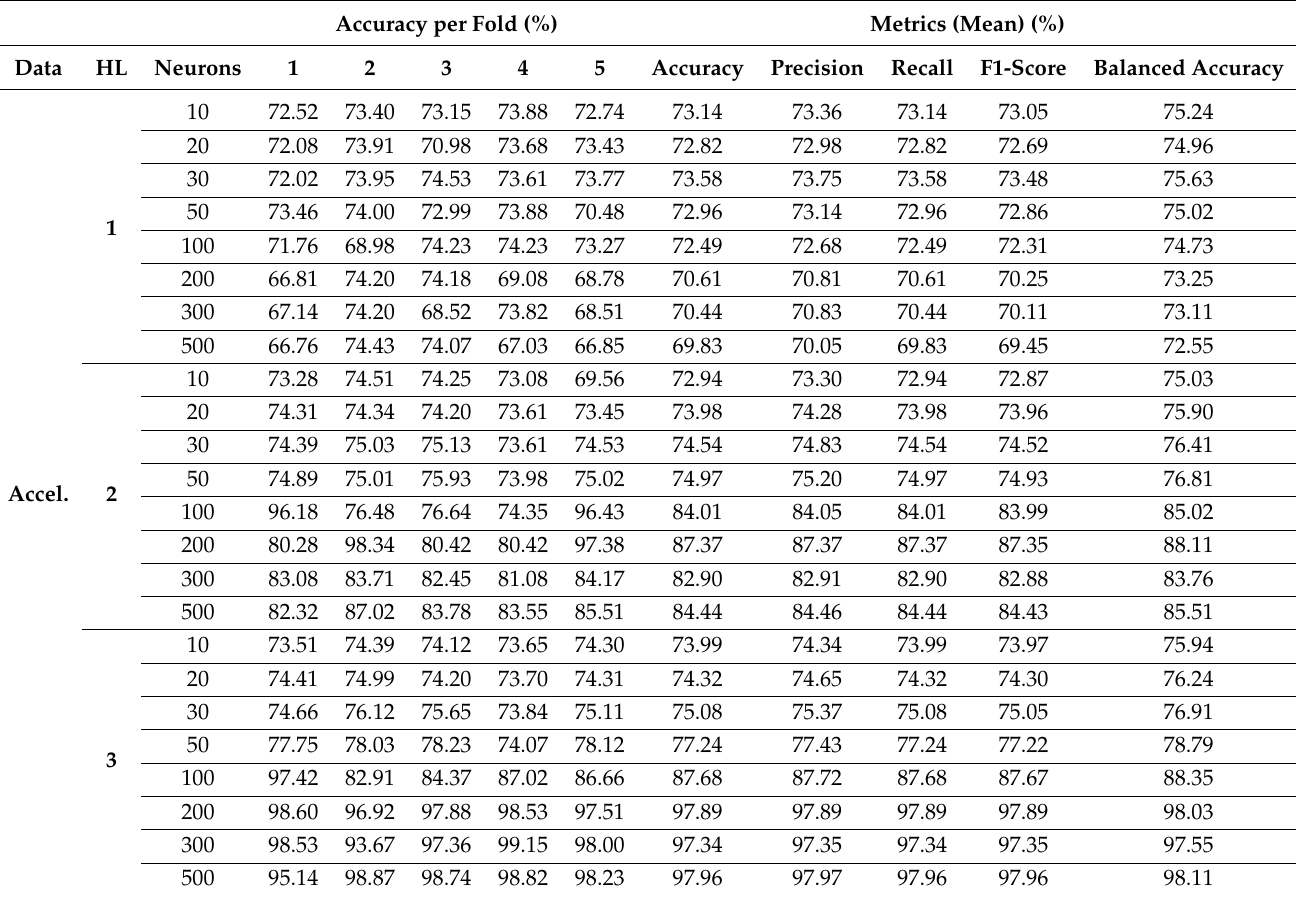
Table A2. Results obtained for the different cross-validation folds for each of the studied configurations. Accuracy per Fold (%) Metrics (Mean) (%) Data